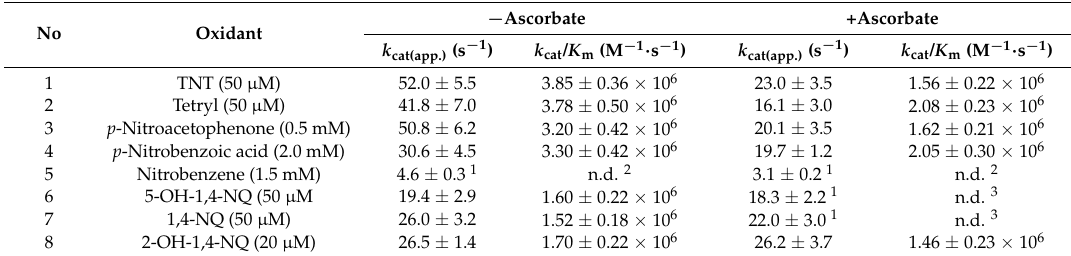
Table 2. The steady-state rate constants of NADPH oxidation by NfsA using various oxidants in the absence and presence of 2.0 mM ascorbate.